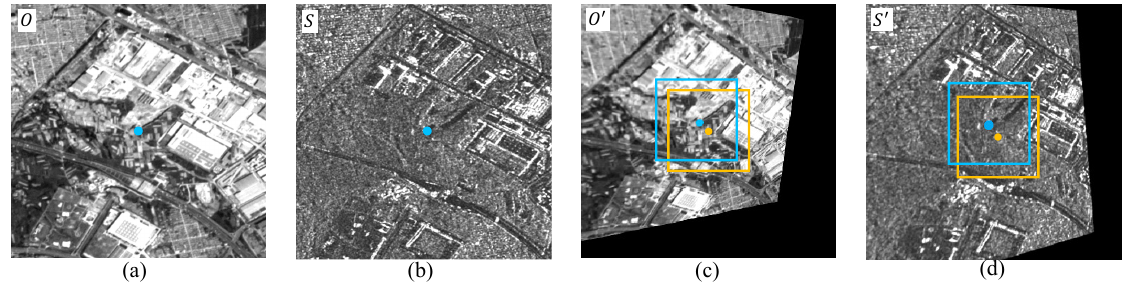
Figure 5. Illustration of the generation process for positive and negative samples. ( a , b ) are the pixel-aligned optical and SAR images ( O and S ). ( c , d ) are the warped images ( O (cid:48) , S (cid:48) ) by random projection transformation